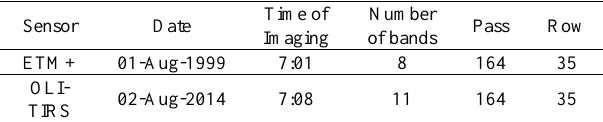
Table 1. characteristics of satellite images used in the